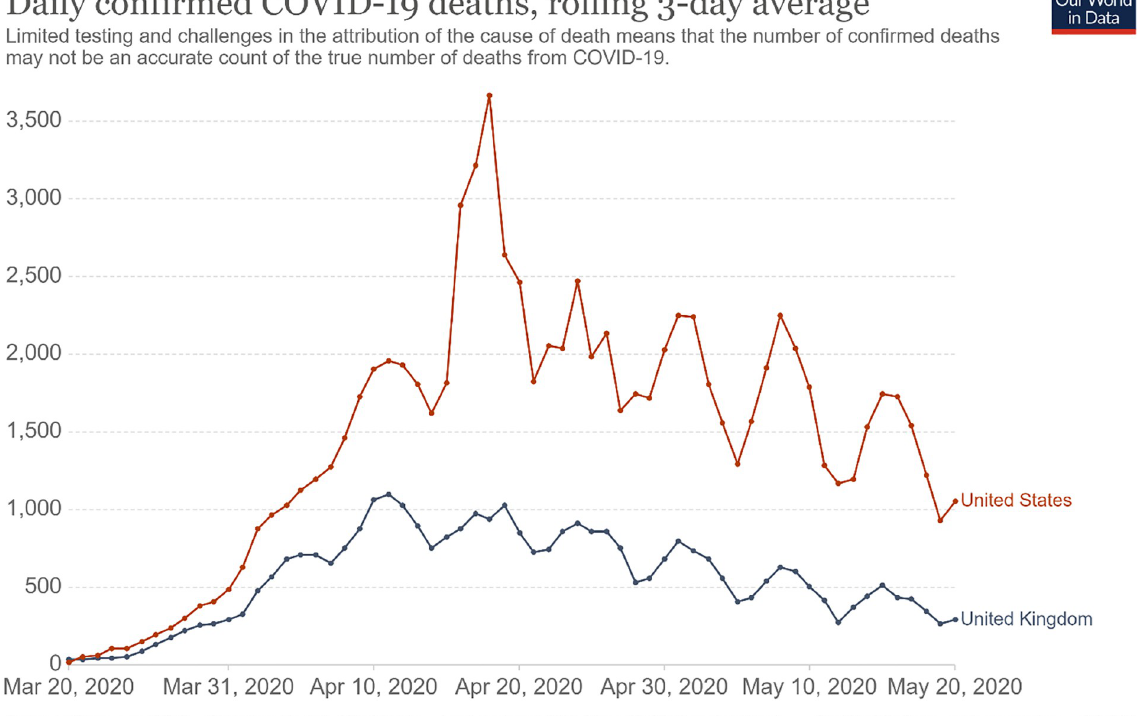
Fig 2. Daily confirmed deaths of COVID-19 between March 20, 2020 and May 20, 2020. Figure retrieved on September 26, 2021 from OurWorldInData.org/coronavirus, which visualized data reported by the European Center for Disease Control. The red rectangle indicates the dates in which the third assessment took place, between April 15 and April